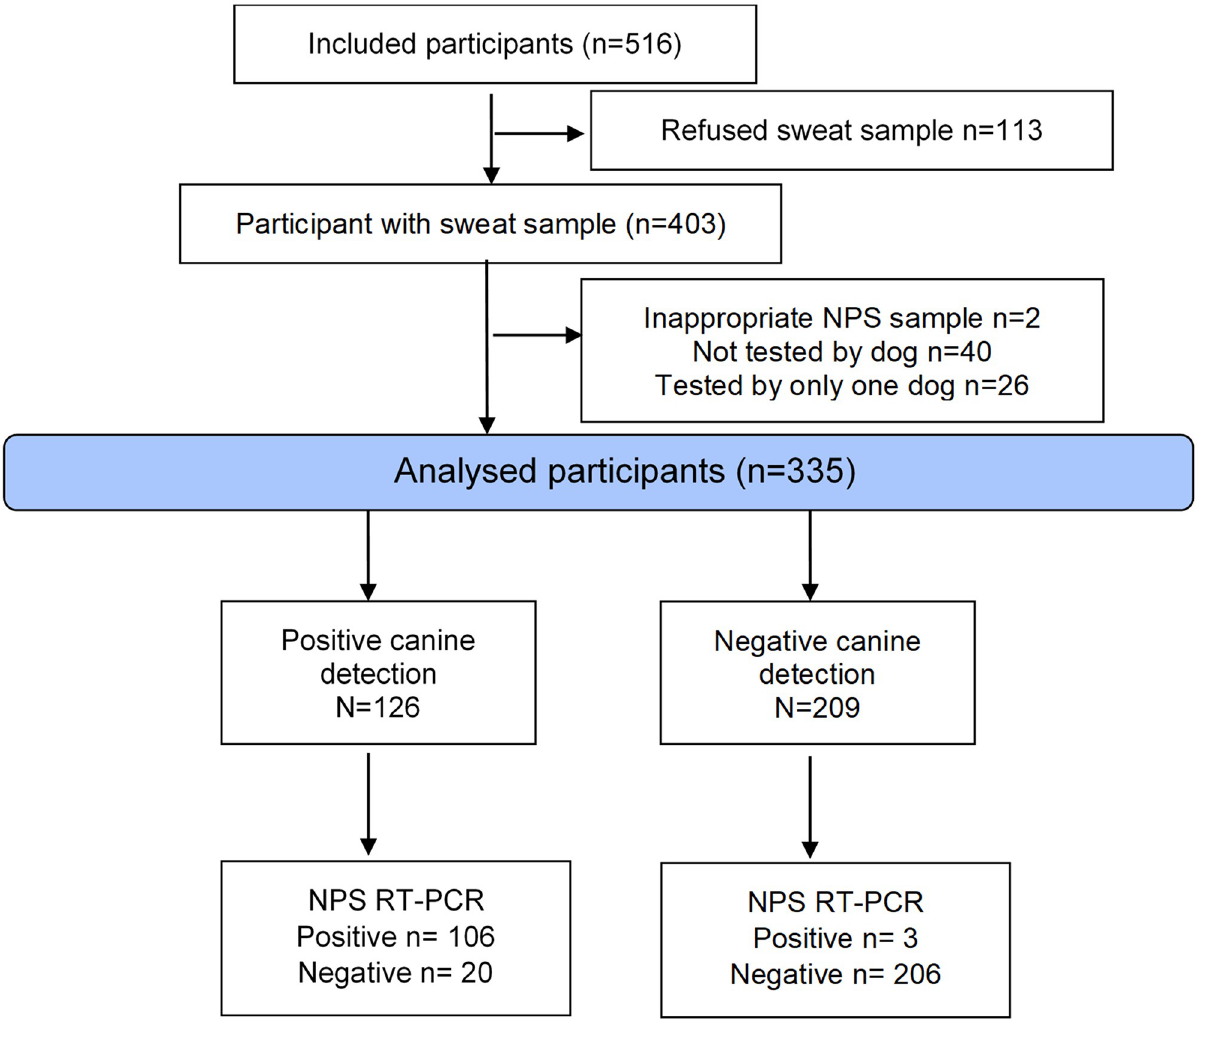
Fig 2. Flowchart of the